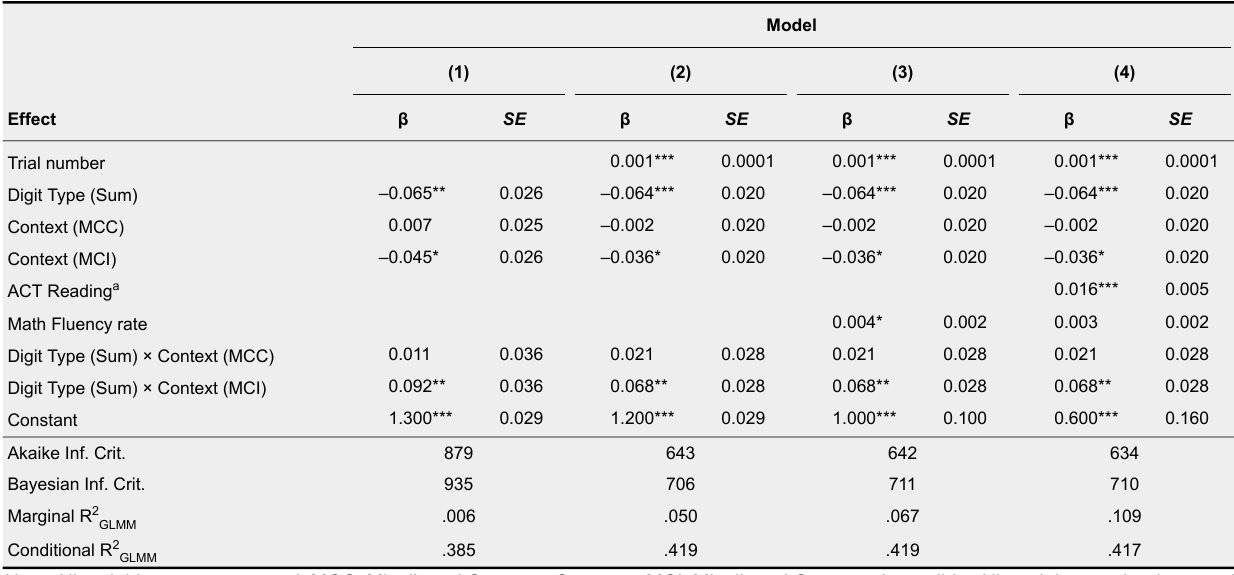
Linear Mixed Effects Regression Weights of Inverse RT (trials/s) on the Number Matching task (n =